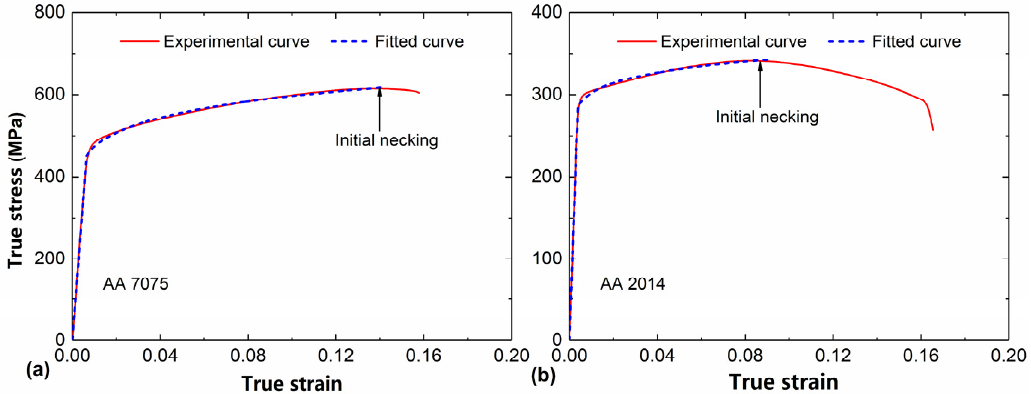
Figure 11. The true stress-strain curves for ( a ) AA 7075 and ( b ) AA 2014 determined by uniaxial tensile tests. Table 2. The average plastic parameters, indentation characteristic parameters, and applied and calculated stresses for AA 7075 and AA 2014.